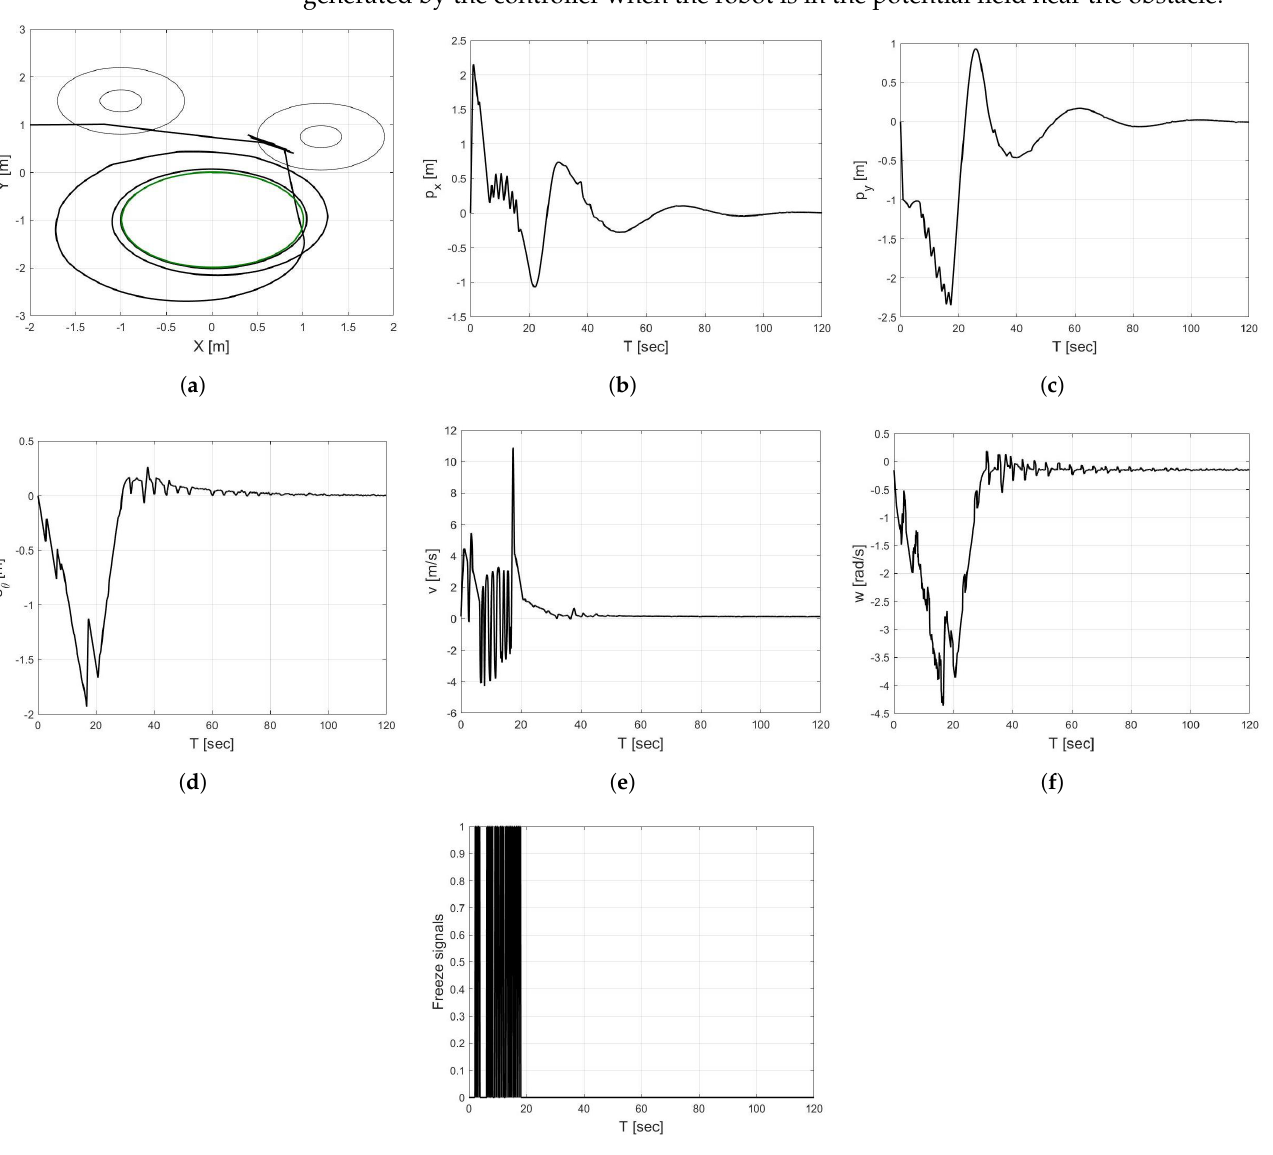
Figure 6. Experiment 2 results—( a ) real and virtual robots path in ( x , y ) -plane; ( b ) position errors in x direction as a function of time; ( c ) position errors in y direction as a function of time; ( d ) orientation errors as a function of time; ( e ) linear velocity control; ( f ) angular velocity control; ( g ) ’freeze’